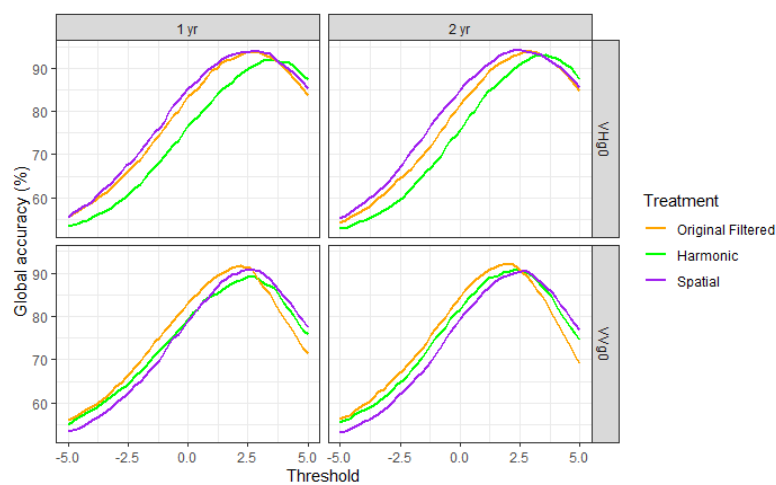
Figure 8. Global accuracy of the maximum likelihood detection procedure.